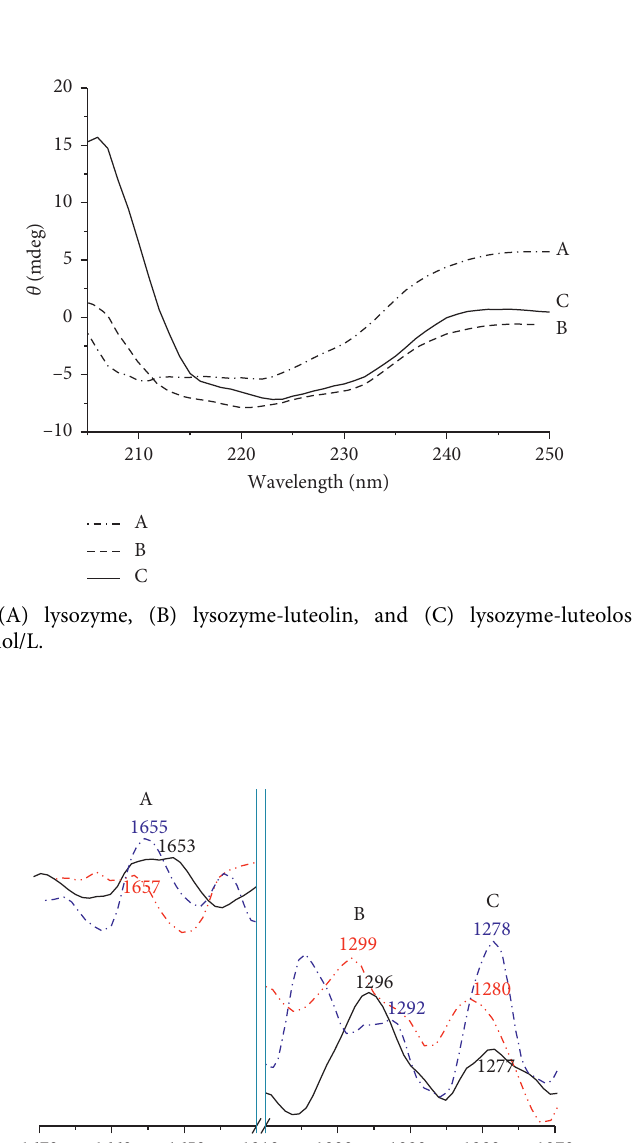
Figure 5: Raman spectra of LYSO (A), (luteolin-LYSO)-luteolin, (B) and (luteoloside-LYSO)-luteoloside (C). C